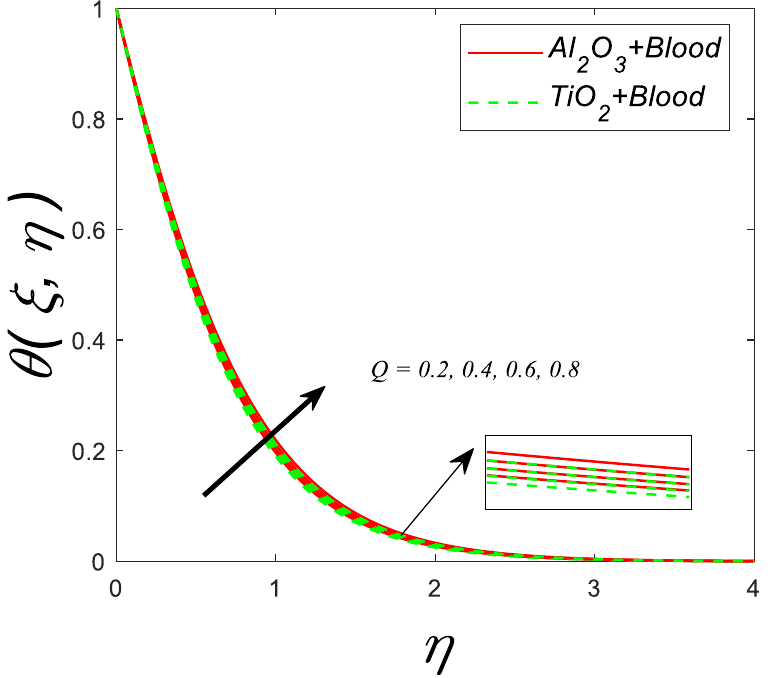
, 𝜉 = 0.1,𝑅𝑑 = , ξ = 0.1, Rd = 0.1, 3 3